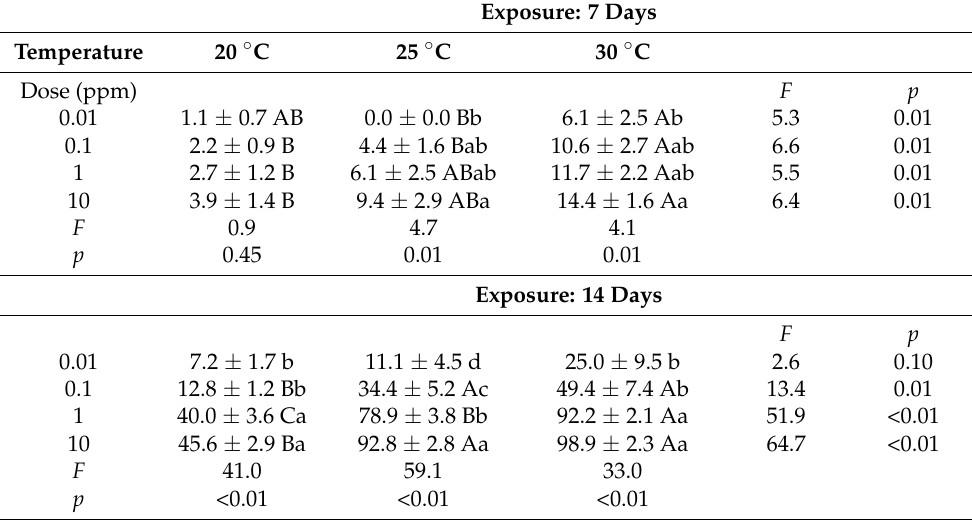
Table 2. Mean mortality (% ± SE) of Prostephanus truncatus adults after 7 and 14 days on maize treated with the WG formulation of chlorantraniliprole, at four doses (0.01, 0.1, 1 and 10 ppm) under three temperatures (20, 25 and 30 ◦ C). Within each column, means followed by the same lowercase letter are not significantly different (in all cases DF = 3, 35, Tukey–Kramer HSD test at 0.05). Within each row, means followed by the same uppercase letter are not significantly different (in all cases DF = 2, 26, Tukey–Kramer HSD test at 0.05). Where no letters exist, no significant differences were